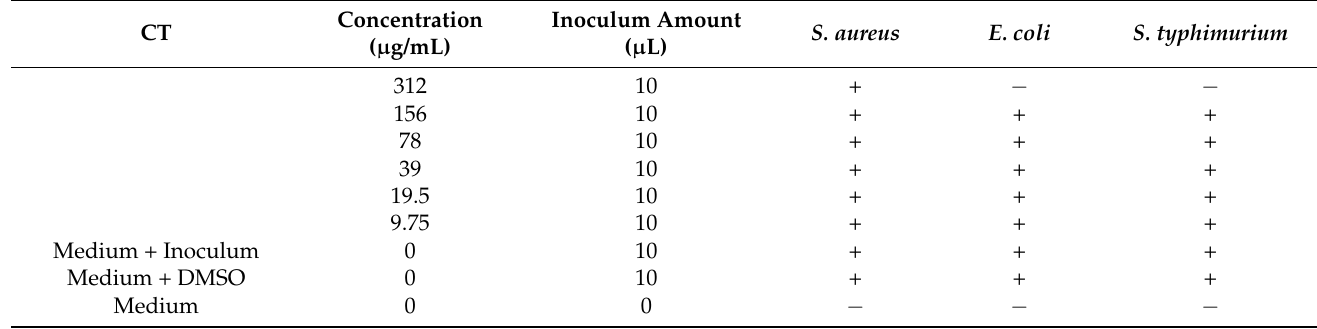
Table 4. MIC (minimum inhibitory concentration) results of CT